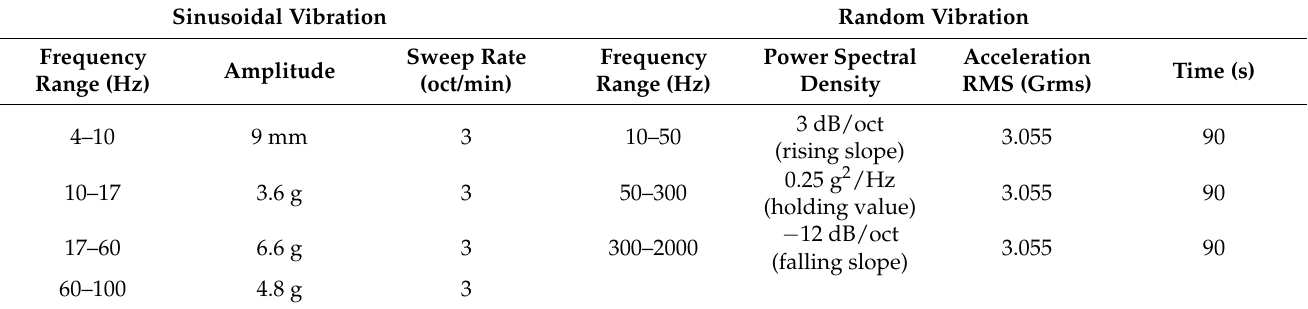
Table 1. Parameters of the vibration tests.